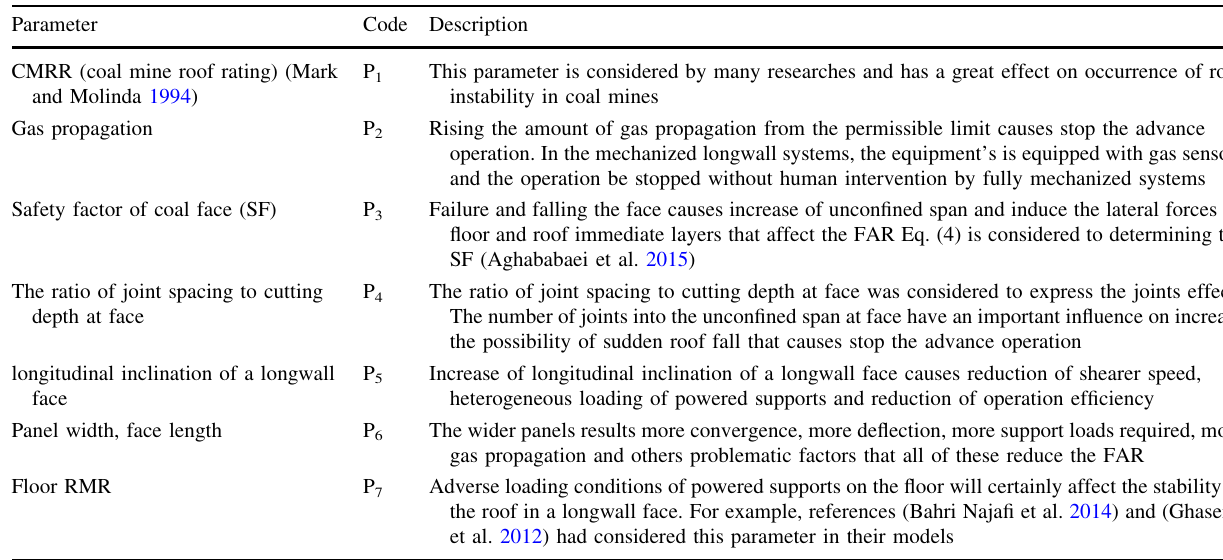
Table 3 Selected parameters influencing the FAR at longwall face to RES-based model Parameter